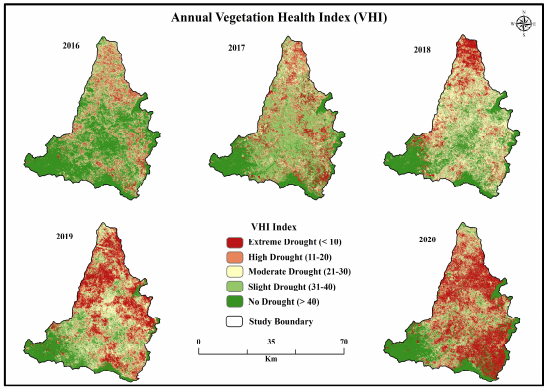
Figure 8: Annual Vegetation Health Index of 2016 to 2020